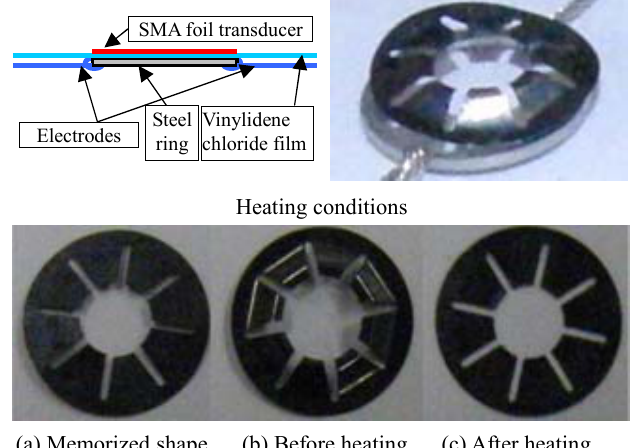
Figure 12. Recovery action of SMA octagonal-pyramidal foil transducer. Table 2. Response time of SMA octagonal-pyramidal foil transducer by Joule’s heating. Initial